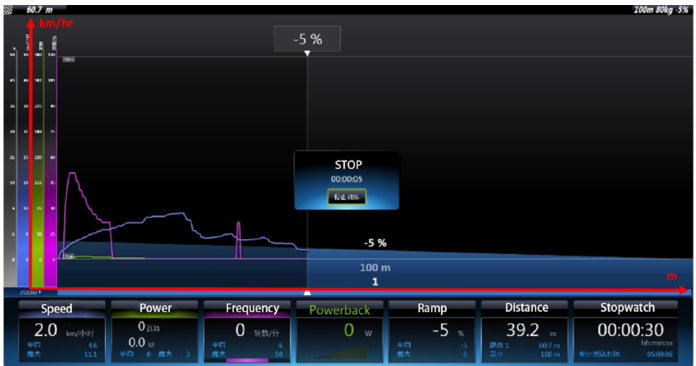
Figure 17. Road slope − 5%, cyclist weight 80 kg, and lower-arm three-phase short-circuit braking.